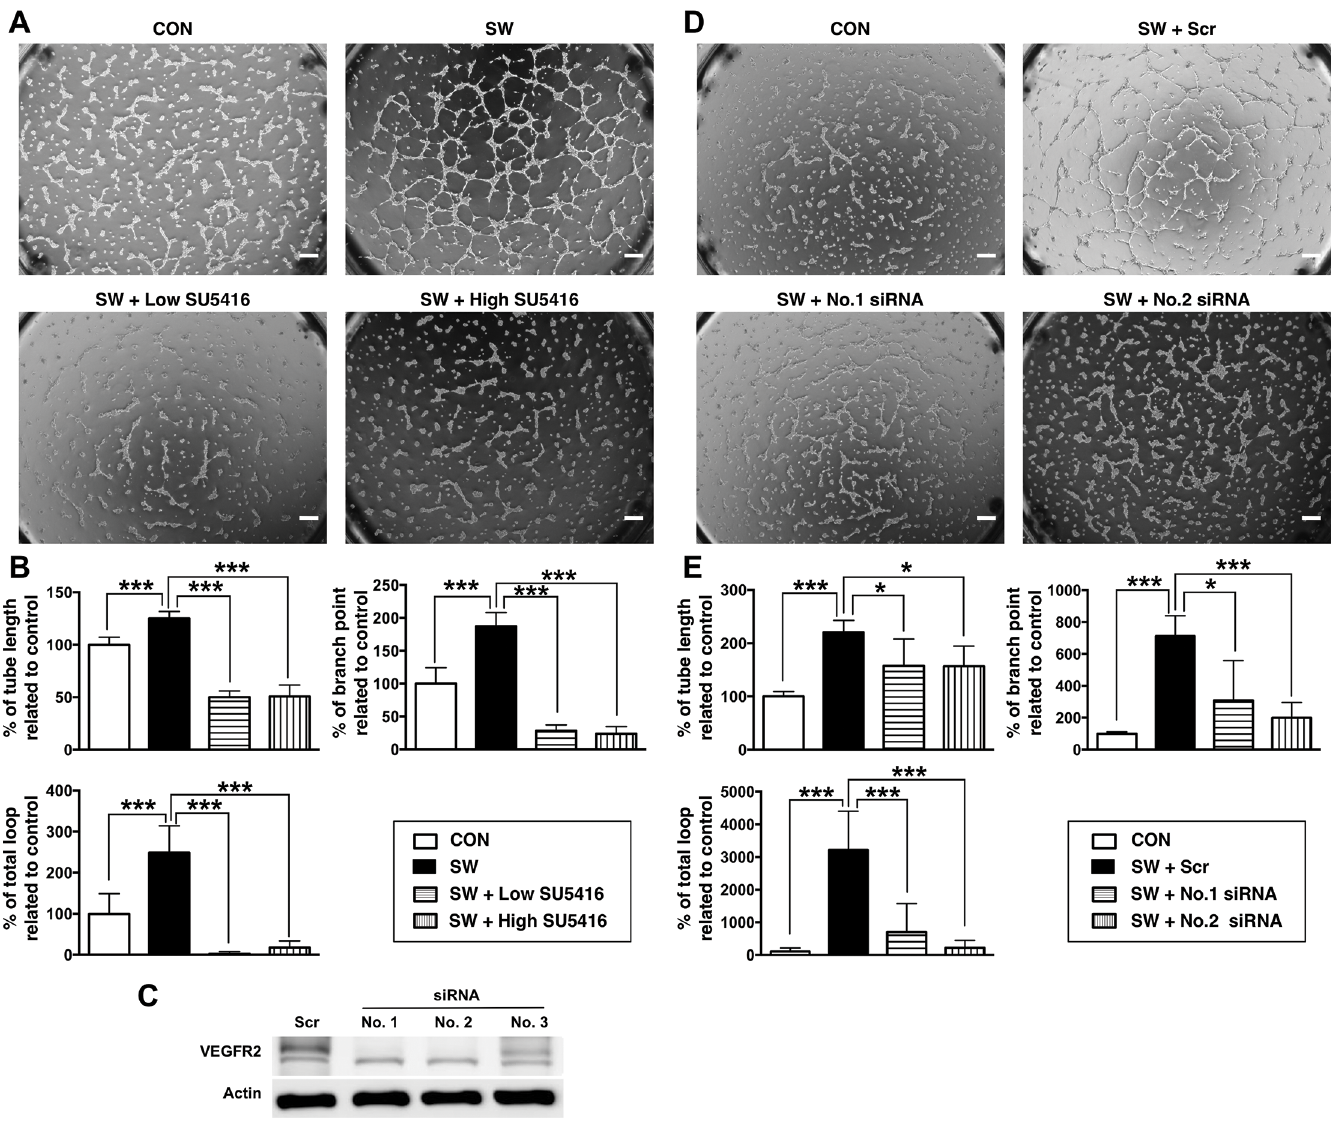
Figure 6. Importance of vascular endothelial growth factor receptor 2 (VEGFR2) in shock wave (SW)-induced angiogenesis. (A) Treat- ment with low-dose (5 μ mol/L) (SW + Low SU5416) and high-dose (15 μ mol/L) (SW + High SU5416) of SU5416 (VEGFR2 kinase inhibitor) in SW-treated HUVECs during tube formation assay. Morphology of tube-like structure at 6 h post seeding. (B) Parameters of tube formation assay, including tube length, branch point and the number of loops (n = 7 in each group). (C) Three different small interfering RNAs (siR- NAs) for VEGFR2 silencing in HUVECs, evaluated by Western blot. (D) No.1 and No. 2 siRNAs-transfected HUVECs applied in tube forma- tion assay, and (E) Quantification (n = 6 in each group). Data shown as mean ± S.D. *** P < 0.0005, * P < 0.05 determined by Student t